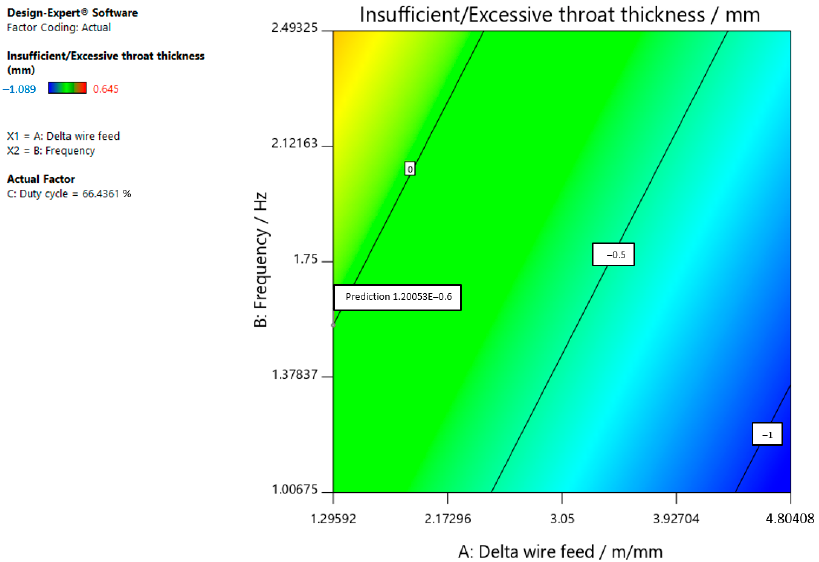
Figure 12. Optimal parameters for achieving the insufficient/excessive throat thickness with a target value of 0.